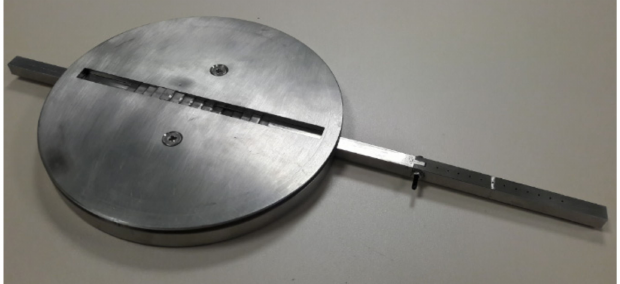
Figure 7. Dedicated calibration specimen used to calibrate the LVDT at ambient temperature and at 300 ◦ C.